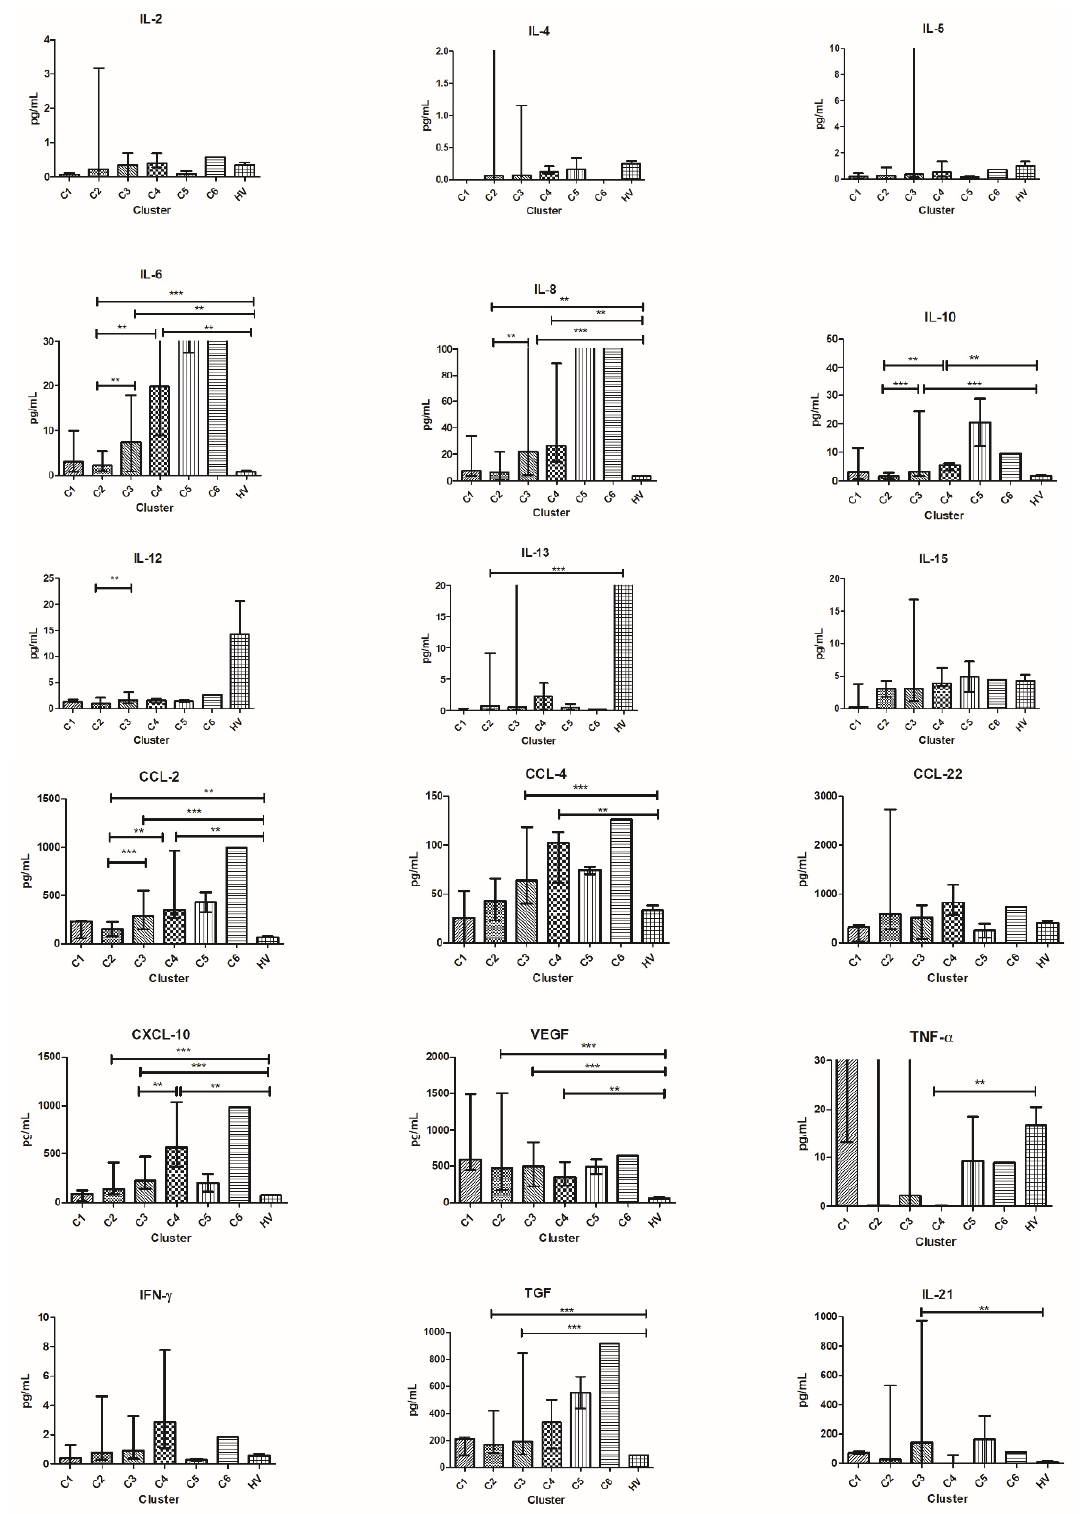
Figure 3. Cytokine distribution at T0 in the six clusters and HV. Plasma concentration is expressed in pg/mL and plotted on the y -axis; clusters of patients are on the x -axis. For TNF- α , IL-4, IL-5, IL-6, IL-8, and IL-13 outliers are not shown for graphical choice. Data are expressed as median with range. *** p < 0.001, ** p < 0.01, * p < 0.05. CCL, C-C motif ligand; IL, interleukin.